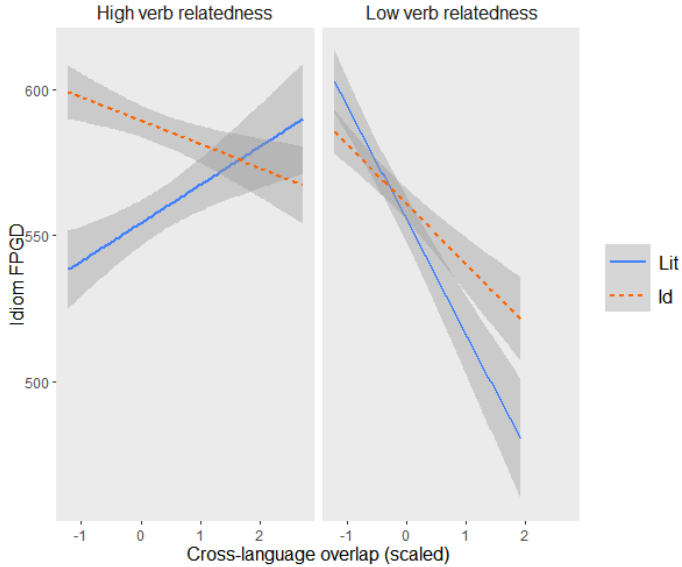
Figure 1. Partial effects plot of first pass gaze duration of the whole idiom region as a function of cross-language overlap ( x -axis) and verb relatedness (median split across the left and right panels) for the idiomatic (Id) and literal (Lit) condition. Error shadings reflect ±1 standard error of the mean.